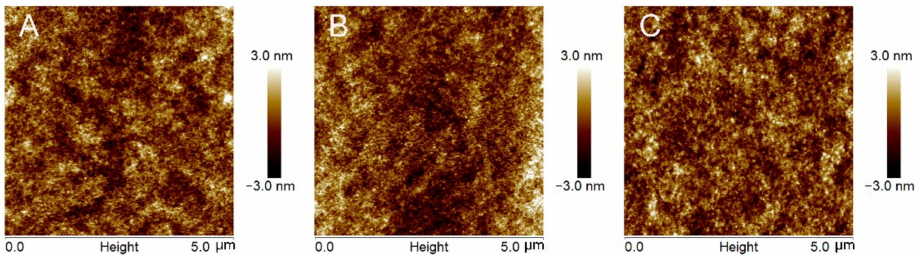
Figure 7. AFM topographic images of PTB7-Th: truxene-centered acceptors blend films, ( A ) PTB7- Th:Tr(Hex) 6 -3RD, ( B ) PTB7-Th:Tr(Dec) 6 -3RD, and ( C ) PTB7-Th:Tr(Hex) 6